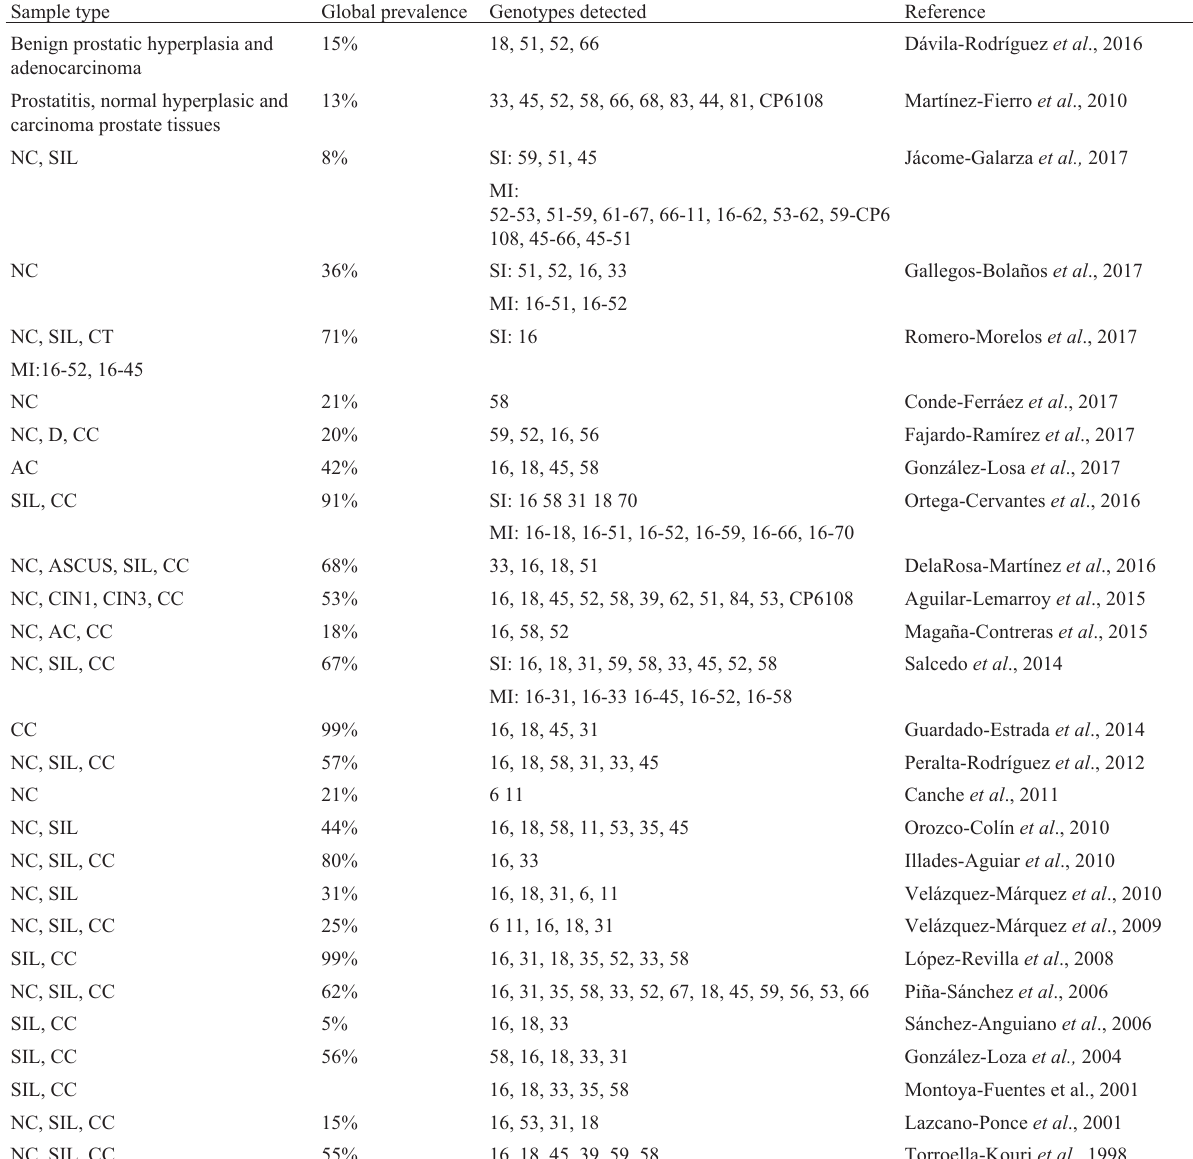
Table 1 - HPV detection in prostate and cervical tissue samples from Mexican population. Sample